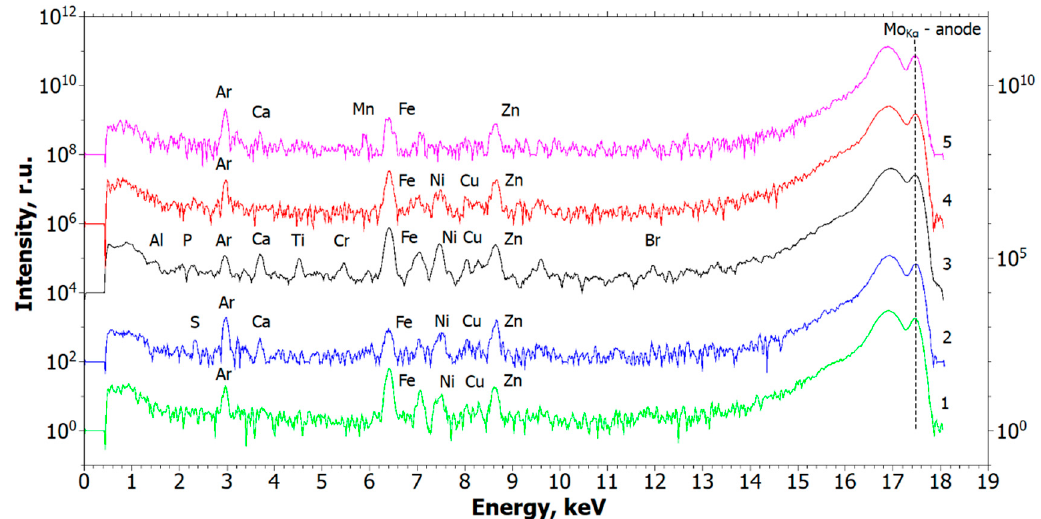
Figure 2. Spectra of samples elemental composition measurements by XRF: (1, 2, 3, 4) Bone bed zones in the area of four spontaneously disintegrated dental implants; (5) Control.